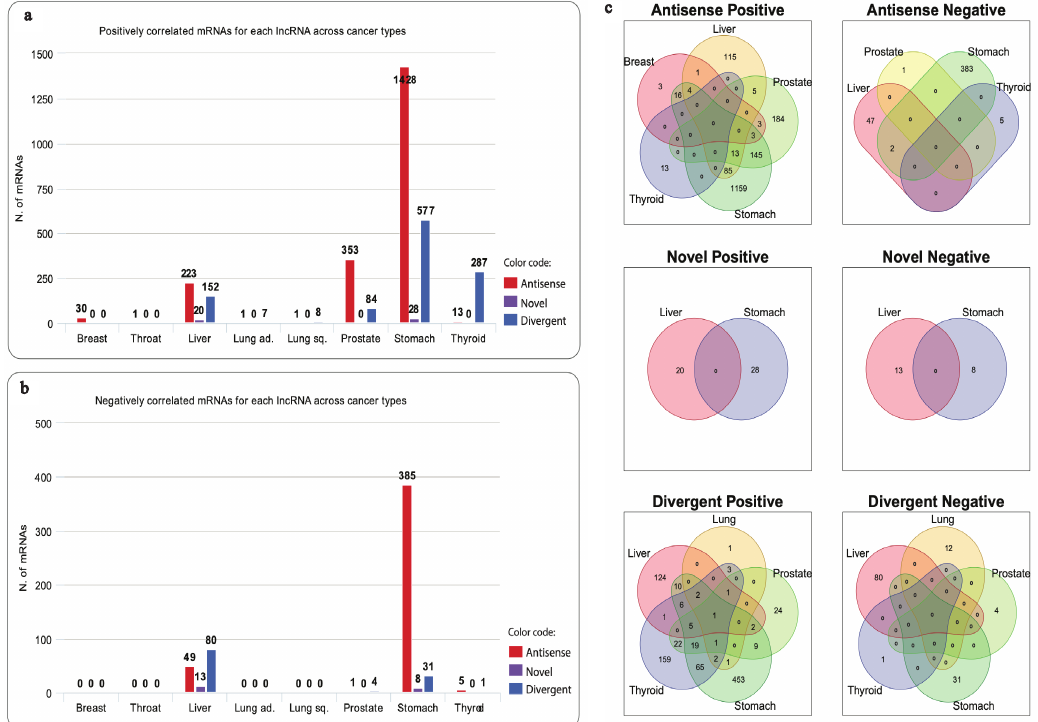
Figure 1. Bar plots showing the number of mRNAs related to the three lncRNAs, per cancer type. Red represents Antisense, purple represents Novel and blue represents Divergent. ( a ) number of positively correlated mRNAs. ( b ) number of negatively correlated mRNAs. ( c ) Venn diagram showing the overlap between lists of positively and negatively correlated mRNAs with lncRNAs: Antisense, Novel and Divergent, across different cancer types: breast (BRCA), thyroid (THCA), stomach (STAD), prostate (PRAD), lung (LUAD and LUSC) and liver